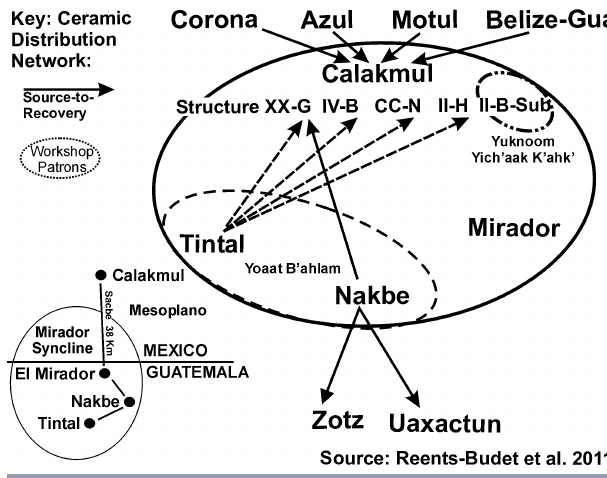
Fig. 4 . Mapping the sources of elite ceramics into Calakmul. The city names along the top are from sources outside the Mirador area. Upward-facing arrows inside the circle, the Mirador area, point to the structures in Calakmul from which ceramics from Tintal and Nakbe were recovered. Downward- facing arrows from Nakbe point to rare cases in which elite ceramics were sent outside the Mirador